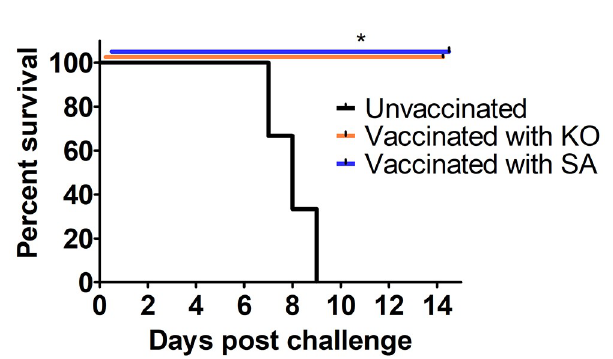
Fig 8. Δ TgPL3 and S1409 parasites induce a protective immunity against subsequent infections. 3 male NMRI mice were infected with 1000 Δ TgPL3 or S1409 parasites, or uninfected as a negative control. 30 days post infection, mice were tested for seropositivity and challenged with 1000 RH Δ Ku80 Δ HPT parasites. Survival was recorded for 14 days post